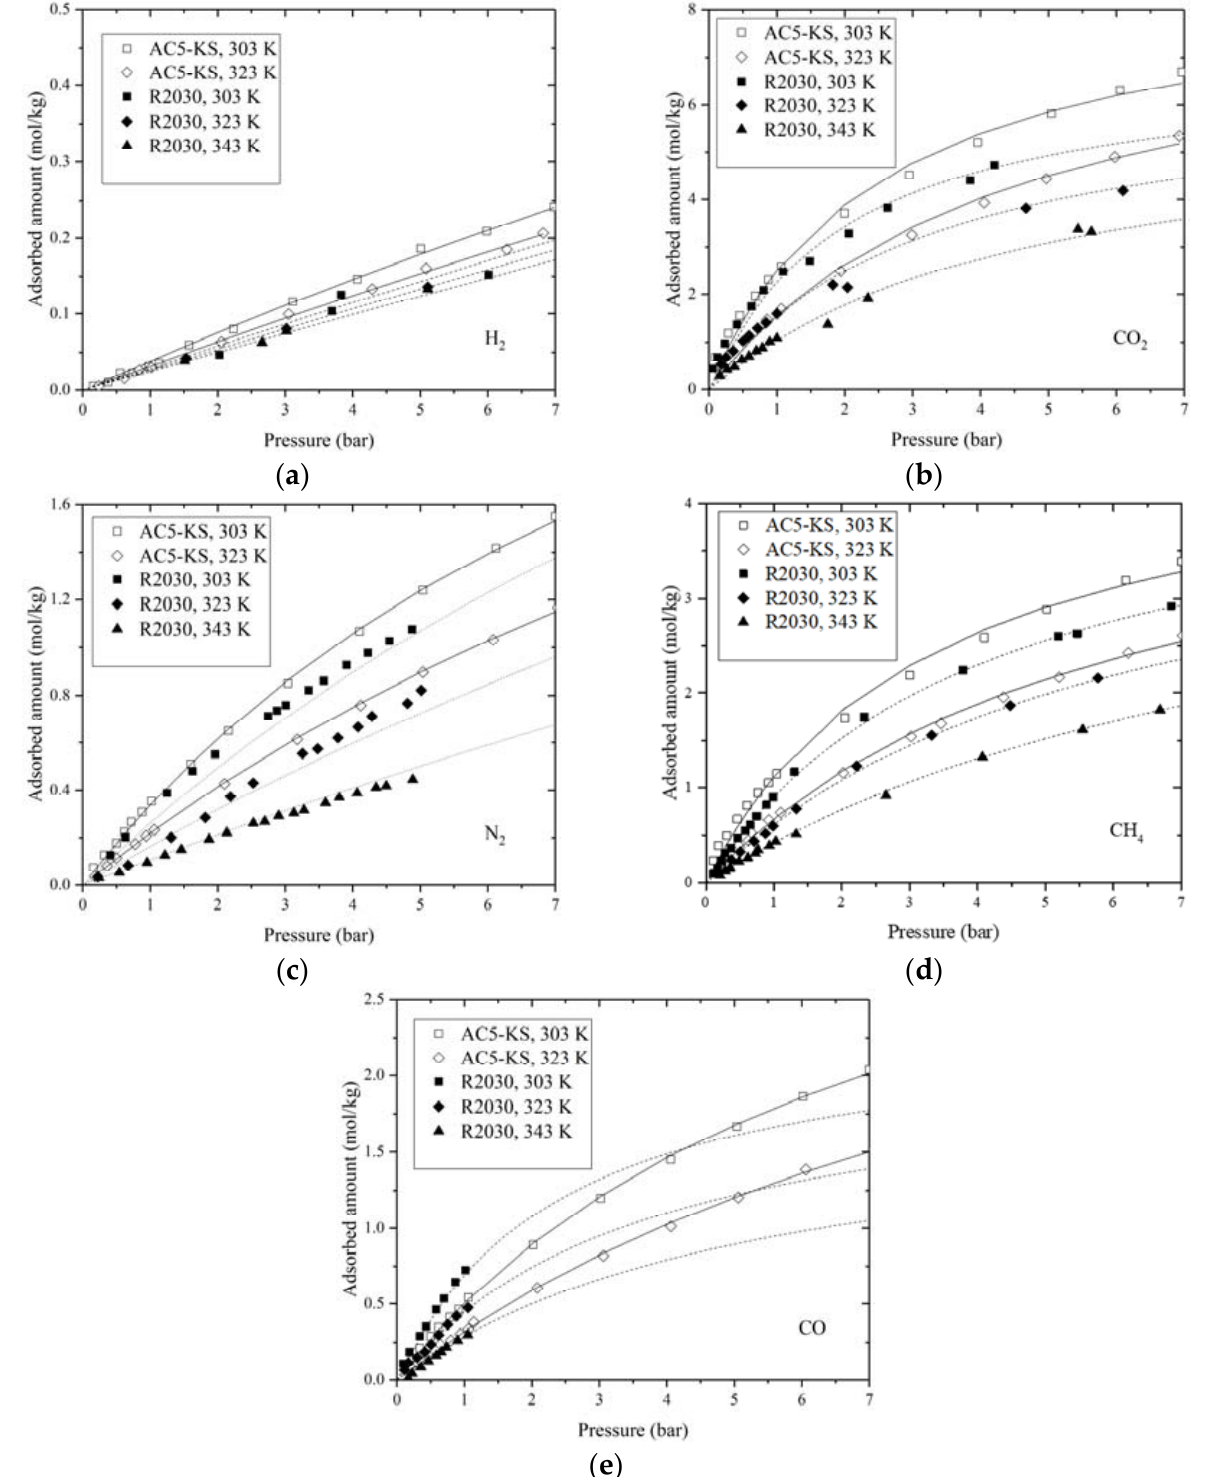
Figure 1. Adsorption isotherms of H 2 ( a ), CO 2 ( b ), N 2 ( c ), CH 4 ( d ), and CO ( e ) on R2030 and AC5-KS. Symbols: Experimental